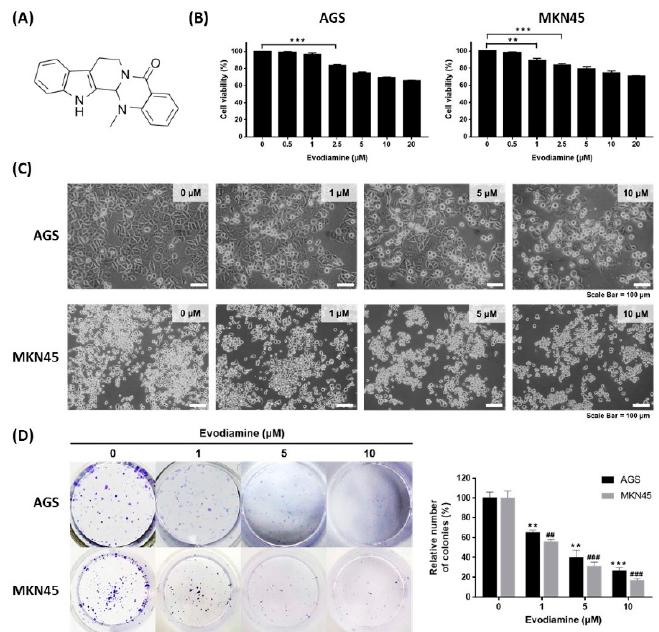
Figure 1. Inhibitory effect of evodiamine on the cell viability of gastric cancer cell lines. ( A ) Chemical structure of evodiamine. ( B ) Gastric cancer cells, AGS and MKN45, were treated with the indicated doses of evodiamine (0, 1, 5, and 10 μ M) for 24 h and cell viability was measured by WST assay. Data were from three independent experiments and analyzed by unpaired Student’s t -tests (** p < 0.01 and *** p < 0.001). ( C ) The images were captured using an inverted microscope (×400). ( D ) Clon- ogenic growth inhibition by evodiamine was evaluated by clonogenic assay and representative im- ages of cells stained with crystal violet are shown. Colonies containing >50 normal-appearing cells were counted visually, and the percentage inhibition of colony formation is illustrated as a graph. Data were from three independent experiments and analyzed by unpaired Student’s t -tests. ** p < 0.01 and *** p < 0.001 vs. the non-treated control in AGS cells; ## p < 0.01 and ### p < 0.001 vs. the non- treated control in MKN45 cells. 3.2. Evodiamine Induces Apoptosis in AGS and MKN45 Cells Since evodiamine has been reported to induce apoptosis in several types of cancer cell lines [4–8], it was investigated whether decreased cell viability was caused by apop- tosis in the current study. AGS and MKN45 cells were treated with 10 μ M of evodiamine for 6, 12, or 24 h and 1, 5, or 10 μ M of evodiamine for 24 h, and then compared with the evodiamine non-treated control group. As a result of the flow cytometric analysis, apop- totic cells were increased in a dose- and time-dependent manner. After exposure to 10 μ M evodiamine for 24 h, in AGS and MKN45 cells, the apoptosis ratio was increased up to 17.6% and 34.6%, respectively (Figure 2).